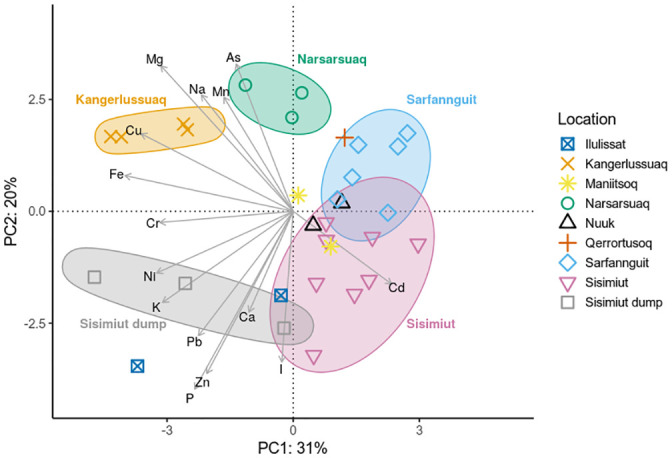
Principal component analysis of element content of Greenland seaweeds depending on geographic location.All samples of F. distichus, F. vesiculosus and Fucus spp. were used in a pooled investigation. Hg and Se were excluded from the analysis due to the low number of quantifiable samples. Ellipses denote locations with at least three samples.